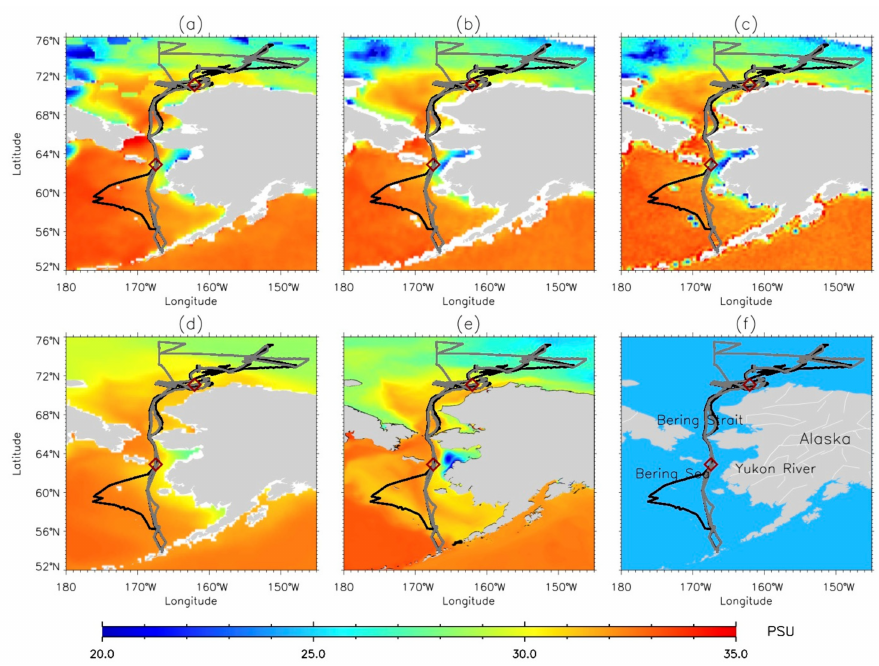
Figure 1. Maps of mean SSS time-averaged over the period of Saildrone deployment. ( a ) SMAP JPL V4.3, ( b ) SMAP RSS 70km, ( c ) SMAP RSS 40km, ( d ) LLC270, and ( e ) LLC4320. Blue values are indicative of low salinity. Overlaid are tracks of Saildrone 1036 (black) and 1037 (grey) deployments. White colors indicate satellite data that was masked due to land contamination. The locations of Saildrones when the two major freshening events occurred (see Figure 2) are indicated by red diamond symbols. ( f ) shows a map with the geographical locations of the study area, including the location of the Yukon River discharge (Y-K delta).